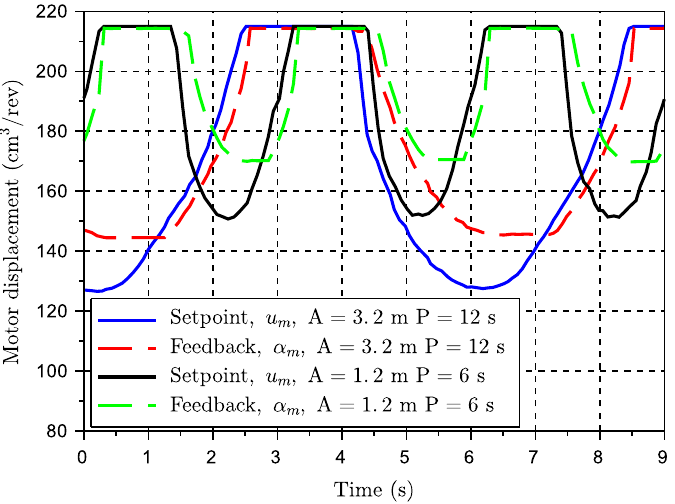
Figure 14. Simulated sinusoidal motion with 12 s period and 6 s period. The motors’ displacement controller runs in open-loop.